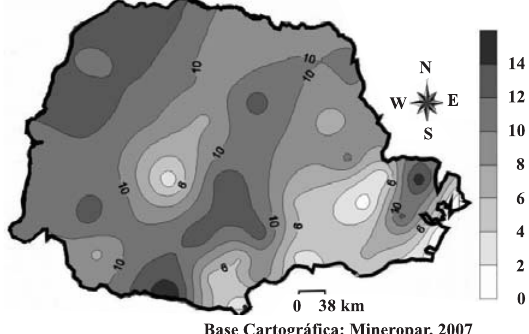
Figura 4. Mapa das oito classes de valores de χχχχχ propostas para o Estado do